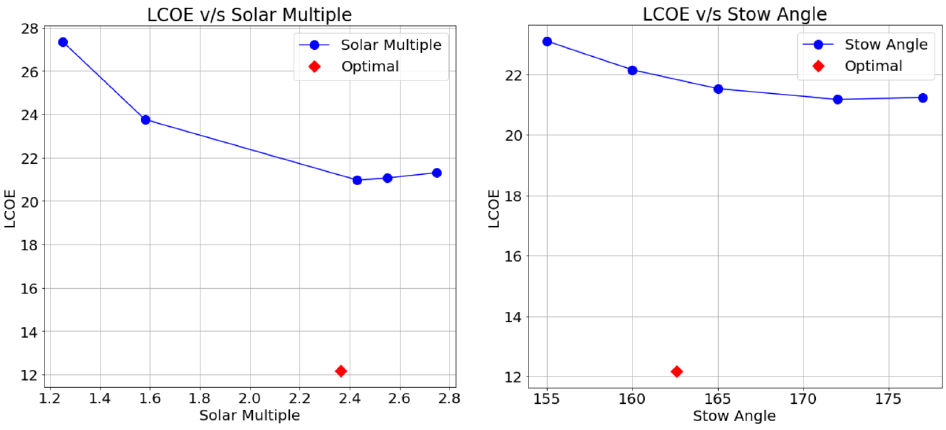
Figure 8. E ff ect of the decision variables solar multiple and stow angle on Figure 8. Effect of the decision variables solar multiple and stow angle on LCOE. 441 Figure 8. Effect of the decision variables solar multiple and stow angle on LCOE. 441 Figure 8. Effect of the decision variables solar multiple and stow angle on LCOE. 441